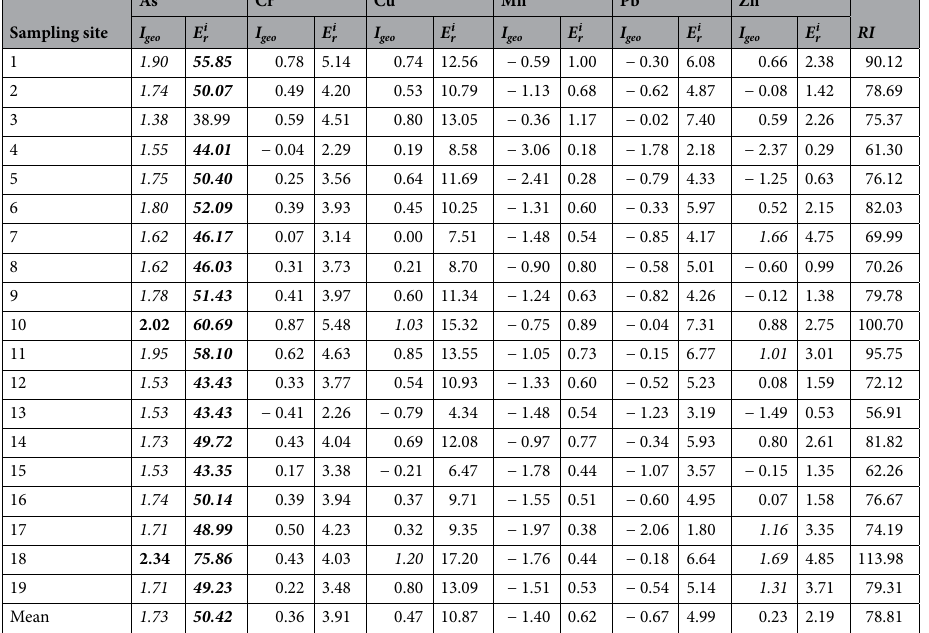
i r in 40–80, moderate ecological